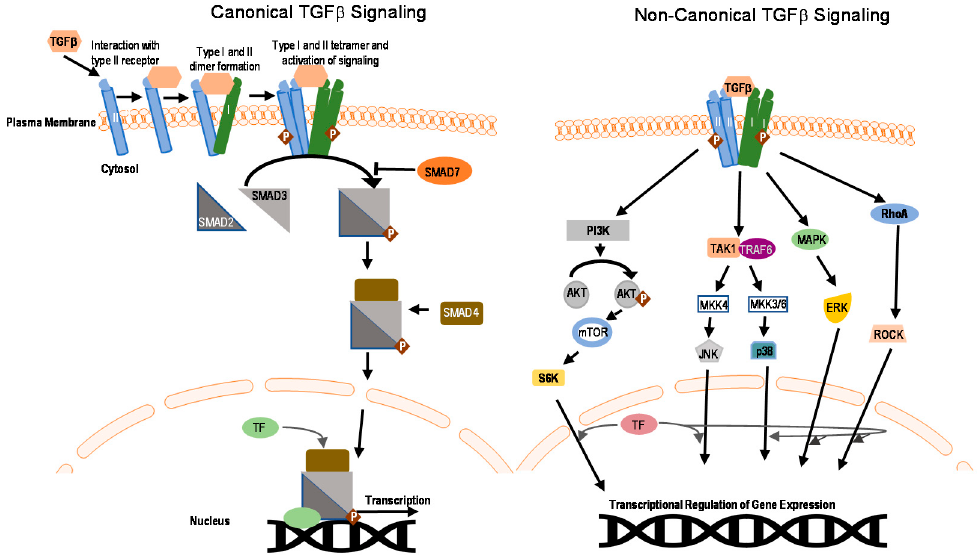
Figure 1. Overview of the transforming growth factor β (TGF β ) signaling pathway. Canonical and non-canonical signaling are shown. TF corresponds to transcription factors. Signaling initiates with binding of TGF β to the receptors and ends with regulating transcription of target genes. I and II represent T β RI and T β RII, phosphorylation is depicted by P.